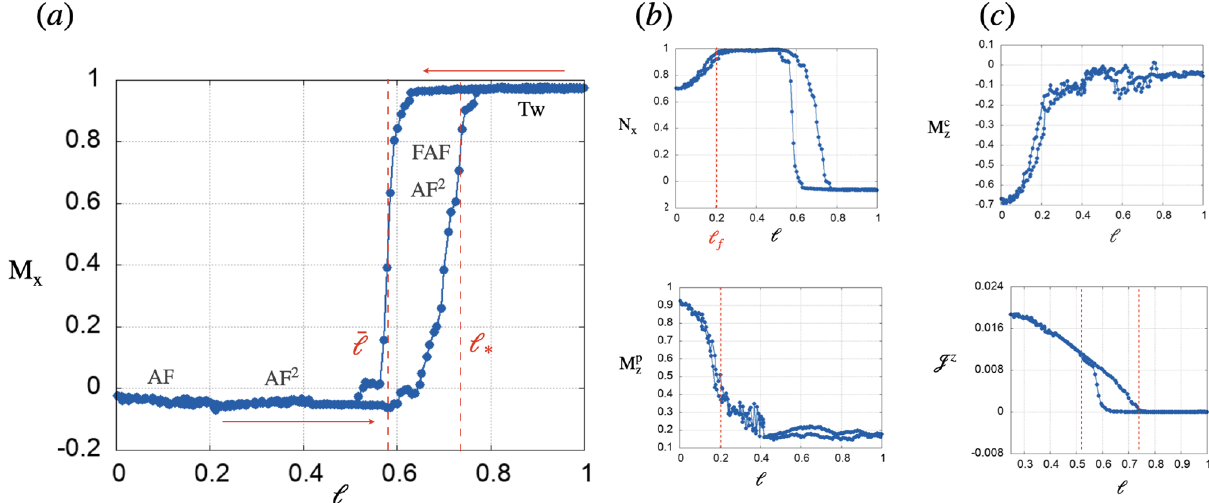
Figure 2. Magnetization dynamics in experiments. ( a ) evolution of M x and (b) (top panel) the staggered x , N x in terms of ℓ . Red arrows pointing to the right and left denote chain p moving apart magnetization along ˆ from and approaching chain c respectively. The bottom panel of ( b ) and the upper panel of ( c ) show the component of the magnetization of the p and c sublattices, respectively. The magnetic current along metastable regime at intermediate ℓ is shown in the bottom panel of figure ( c